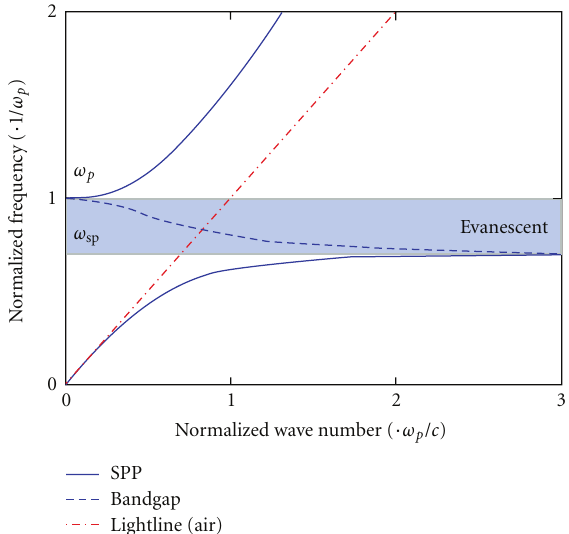
Figure 5: Dispersion relation of SPP (solid) in metal-insulator configuration. The curve for the frequency between 0.707 and 1 denotes imaginary propagation constant.